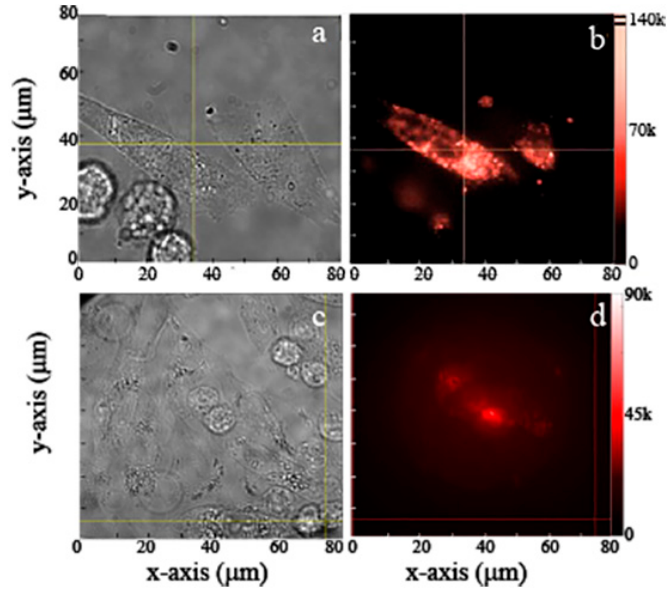
Figure 8. Prostate cancer cells cultured with ( a , b ) commercial and ( c , d ) ball-milled MgO NPs. ( a , c ) Bright field and ( b , d ) widefield fluorescence images of selected areas on the sample. Excitation power was 300 mW at the back of the objective distributed over a widefield scan area of 80 × 80 µ m 2 . This provides an average power of 45 µ W / µ m 2 on the sample’s surface.